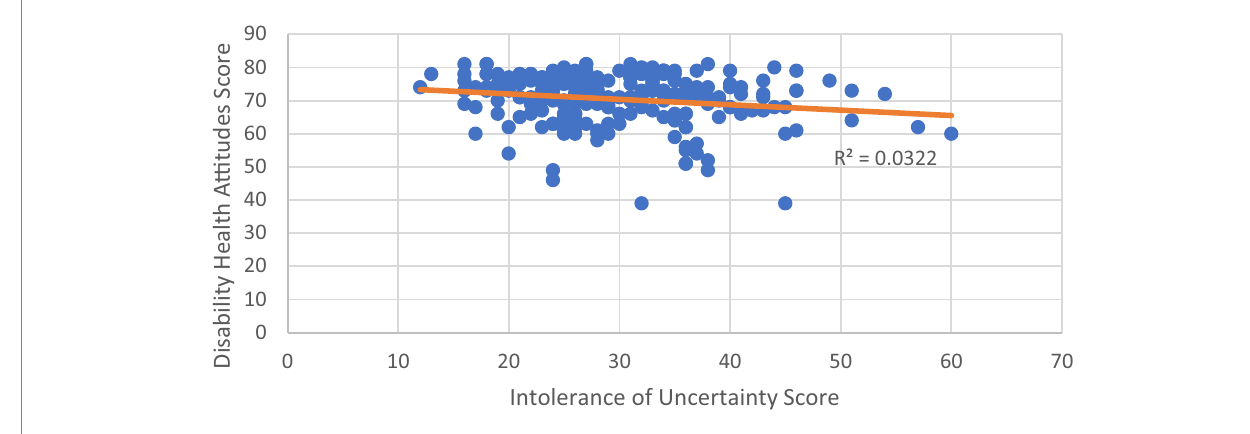
FIGURE 1 Linear regression between intolerance of uncertainty scale (IUS) and disability attitudes in healthcare (DAHC)